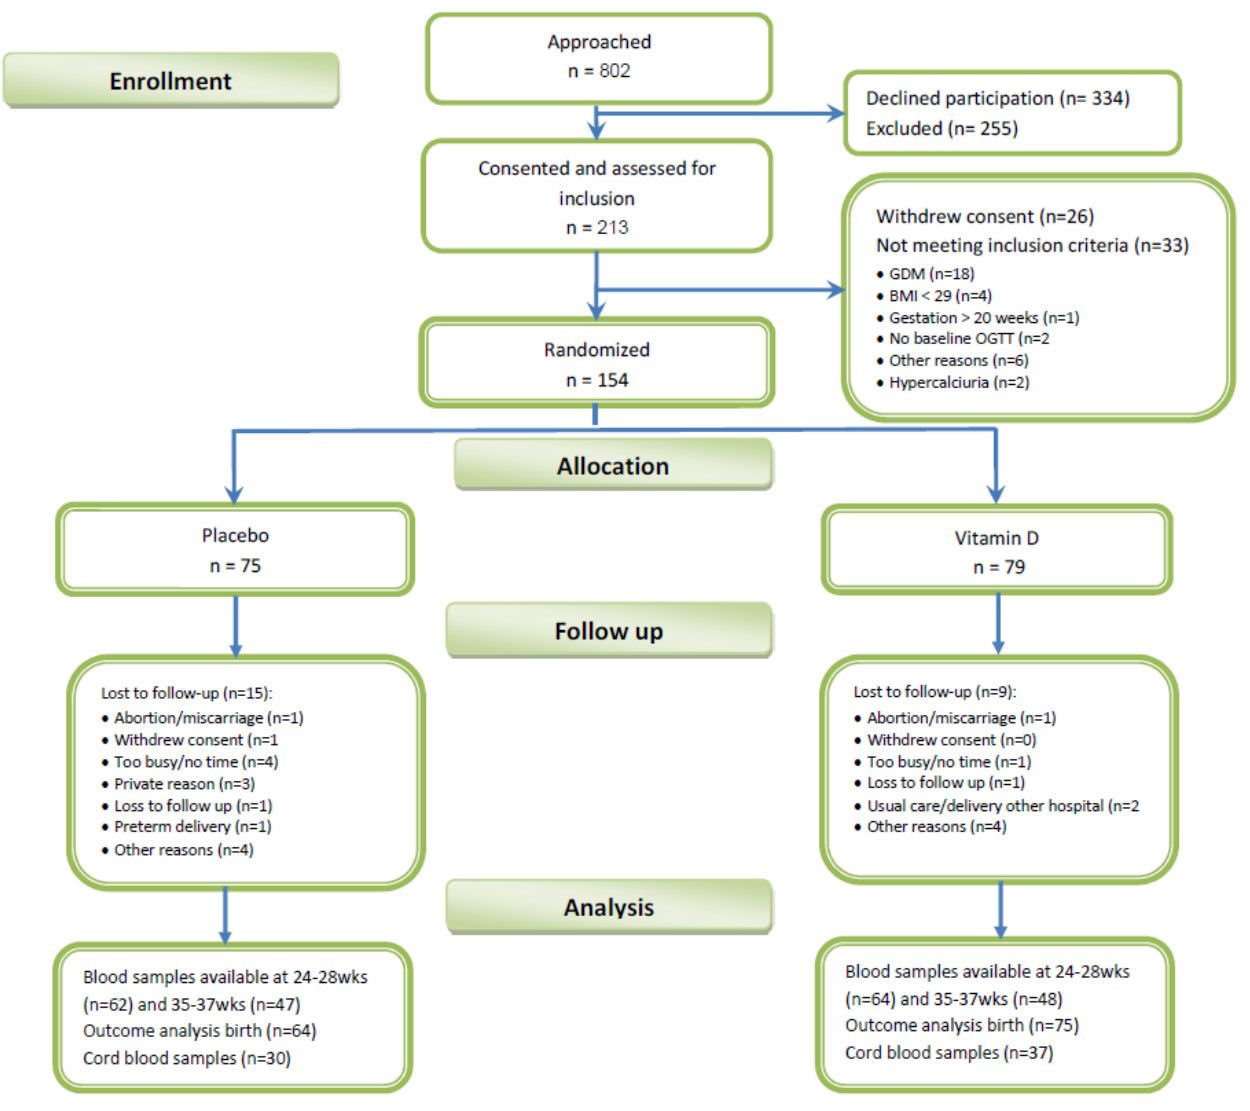
Figure 1. Study flow chart.